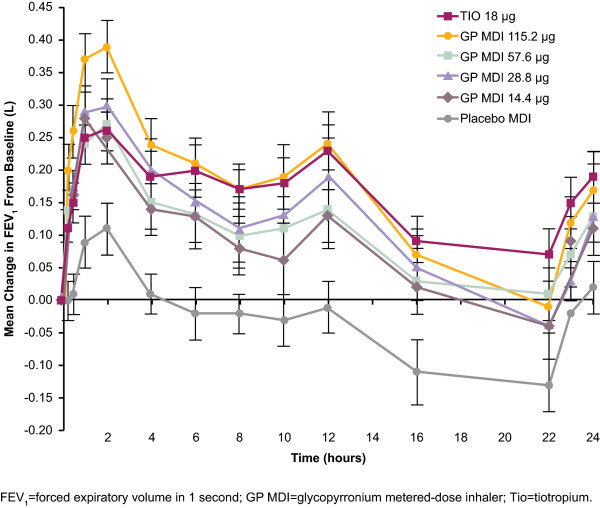
Mean (±standard error) change from baseline in FEV
1
over 24 hours by treatment; represents the results for the peak change in FEV
1
(the primary efficacy endpoint) as well as the change in FEV
1
from test-day baseline over time.